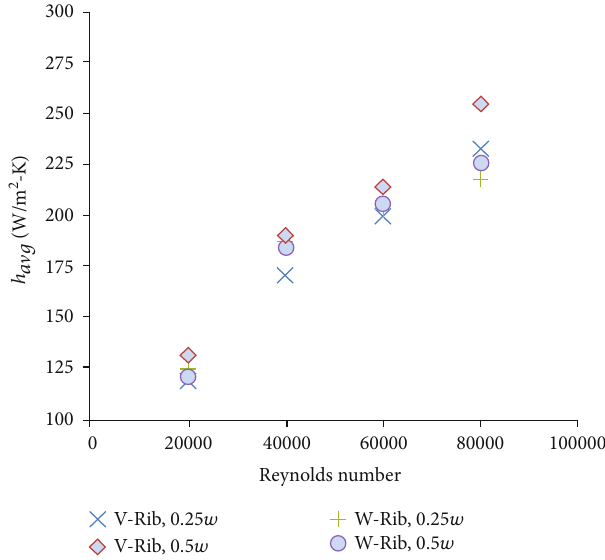
Figure 4: Variation in span averaged heat transfer coe ffi cient ( h